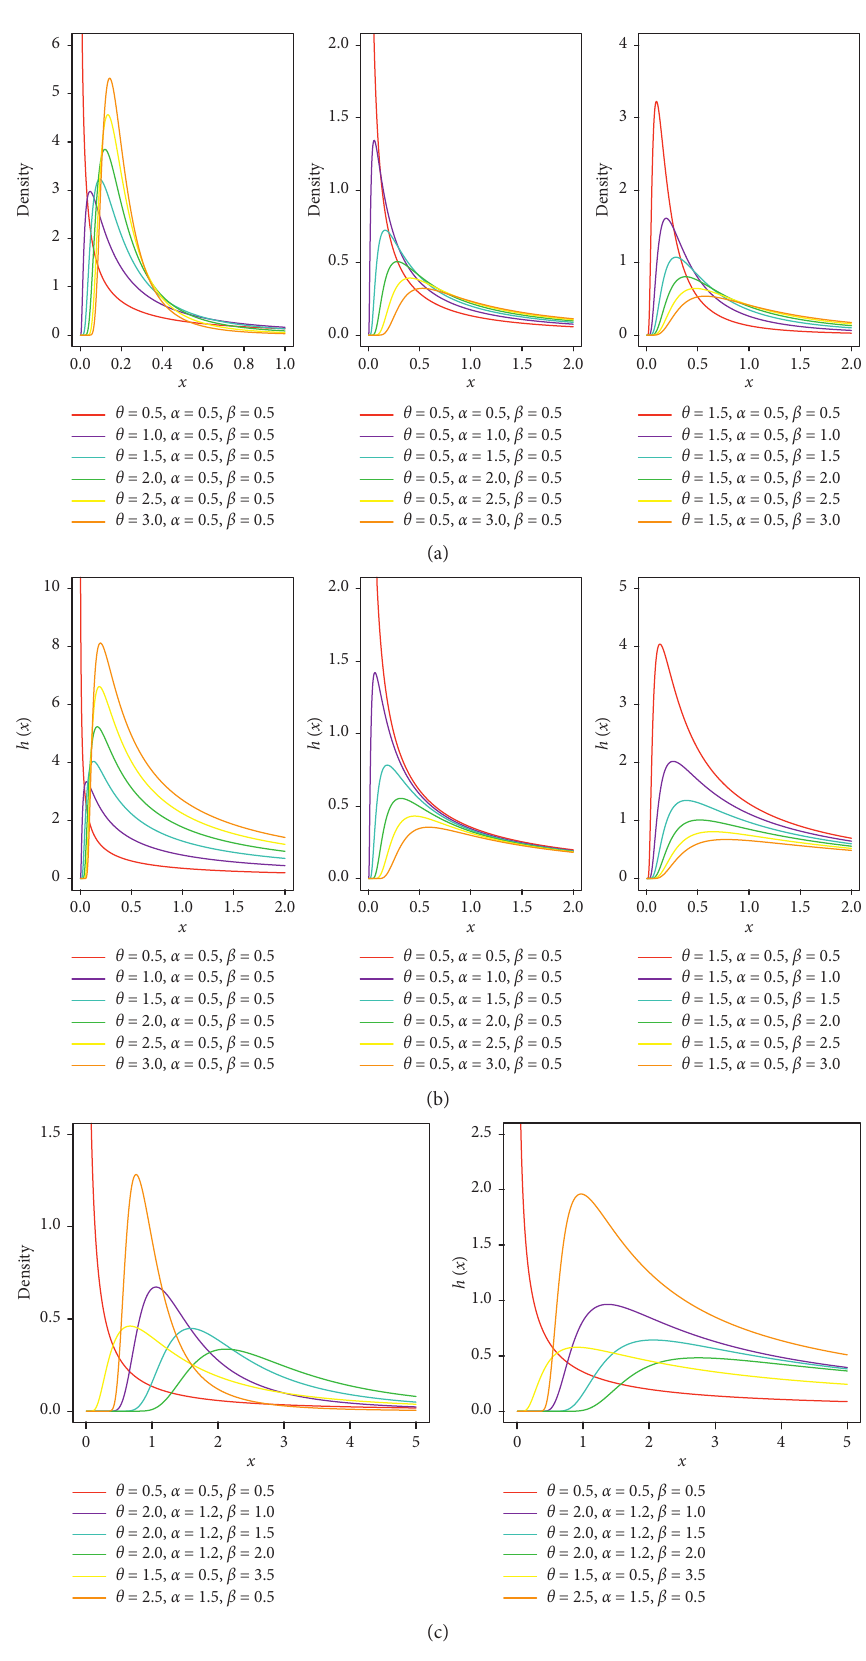
Figure 1: (a) The pdf plots of the OFIL distribution. (b) The hrf plots of the OFIL distribution. (c) The pdf and hrf plots of the OFIL